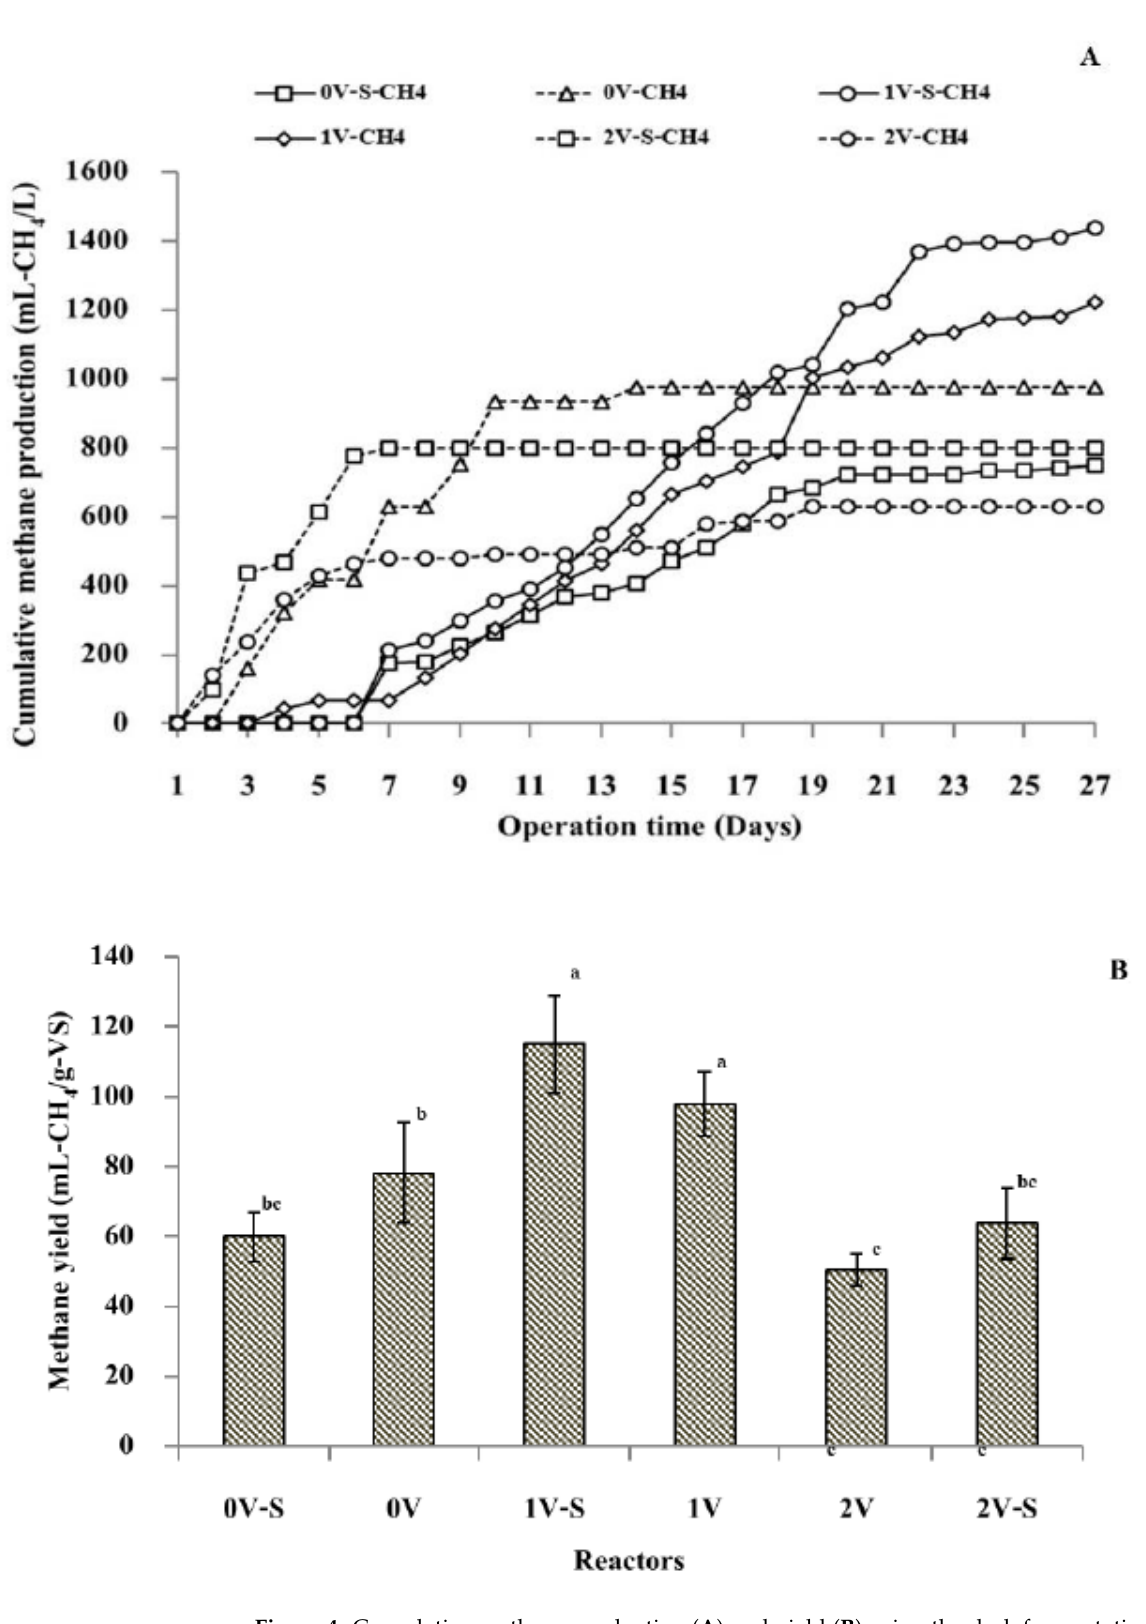
Figure 4. Cumulative methane production ( A ) and yield ( B ) using the dark fermentation effluent in the microbial electrolysis cell reactor at various voltages. Different lowercase letters indicate significant differences between reactor at different operation conditions ( p <